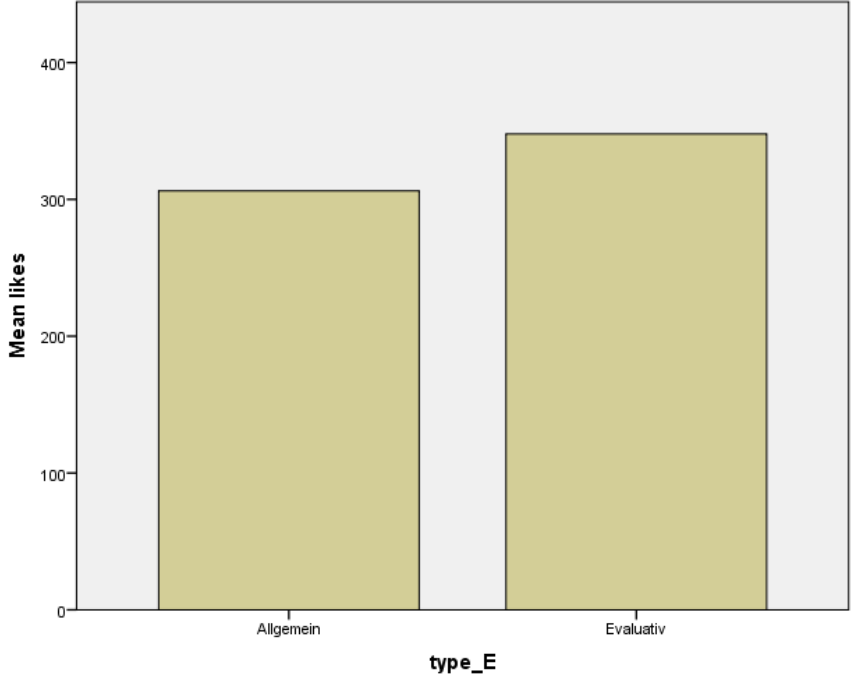
Figure 6. Mean Likes on both Social Media